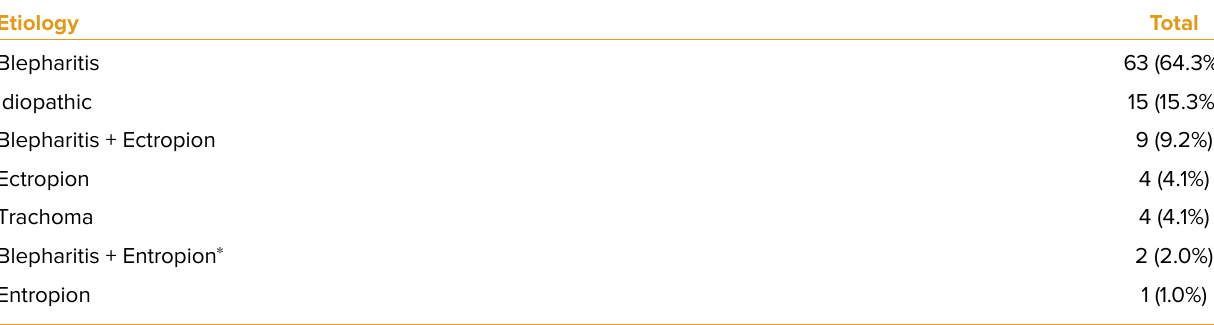
Table 1. Etiology of trichiasis in patients treated with diode green laser